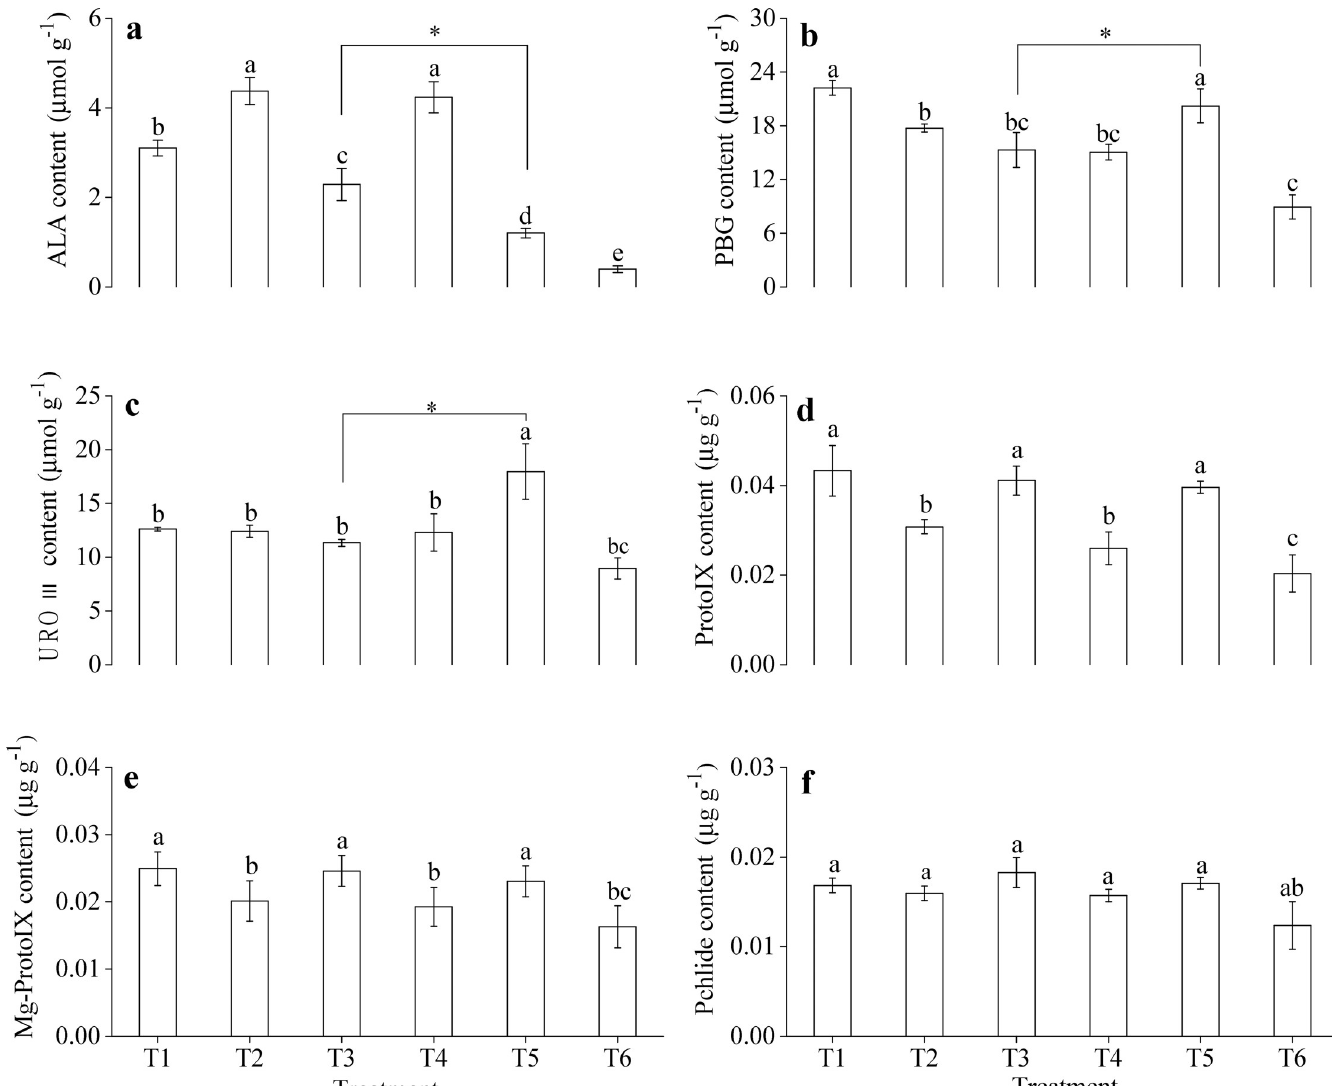
Fig 4. Effects of exogenous Suc on Chl precursor contents in the leaves of M . halliana . (a) ALA content. (b) PBG content. (c) URO III content. (d) Proto IX content. (e) Mg- Proto IX content. (f) Pchlide content. Data are the mean ± SD (n = 3). Different letters indicate significant differences among treatments ( P < 0.05).